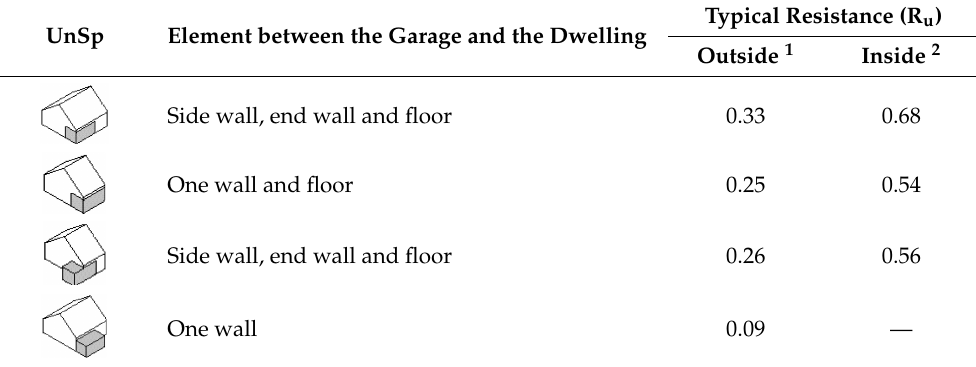
Table 3. Typical R u values for integral and adjacent single garages or other similar UnSp (adapted from [11]).